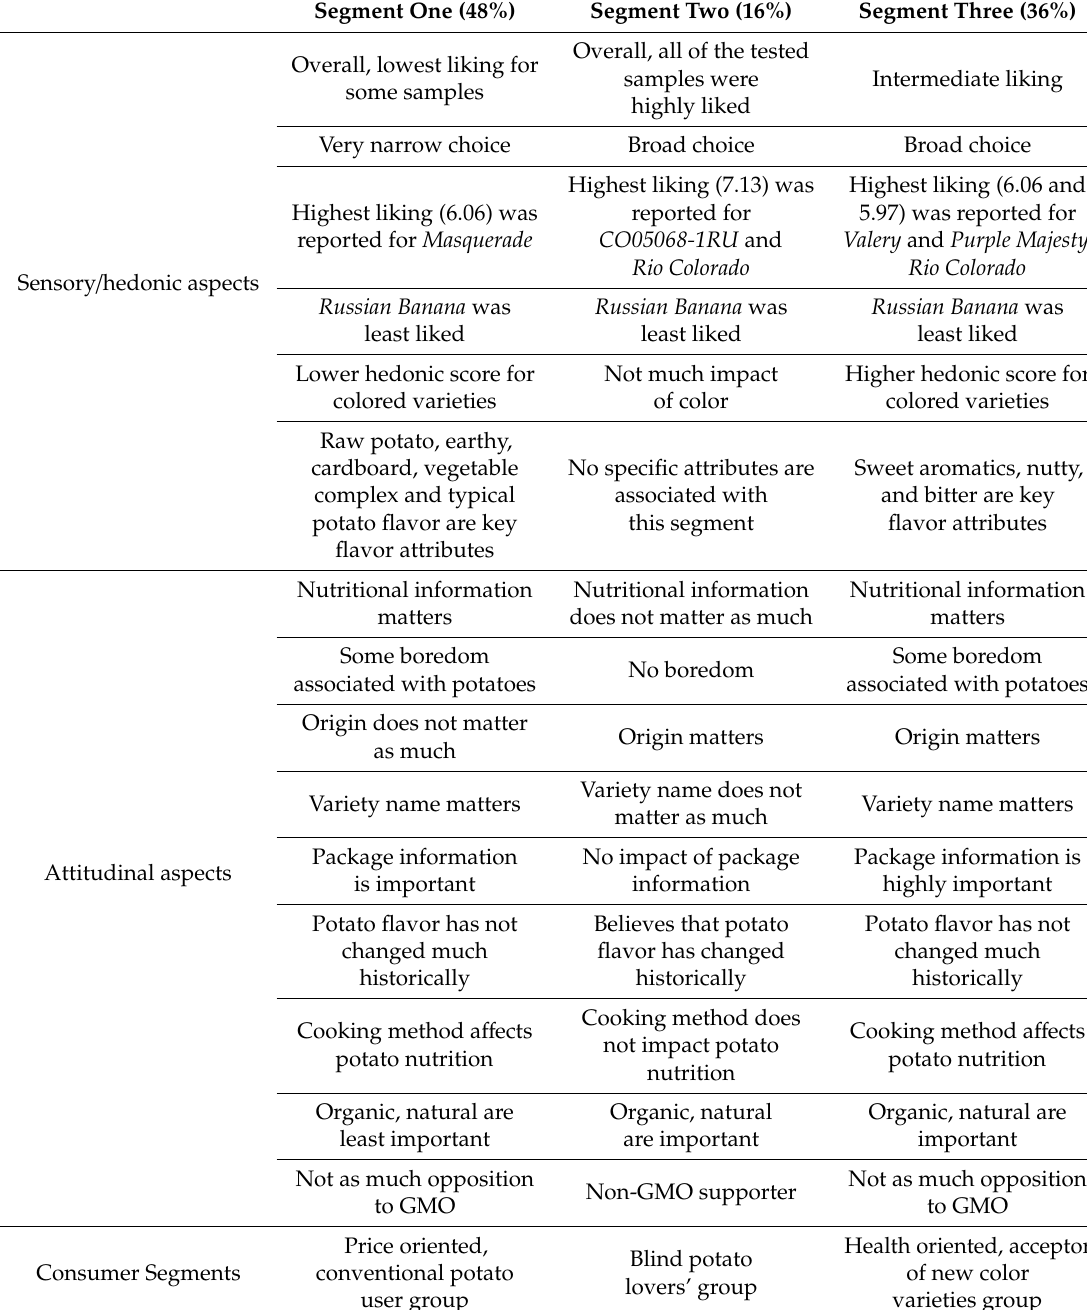
Table 4. Sensory and attitudinal properties of obtained